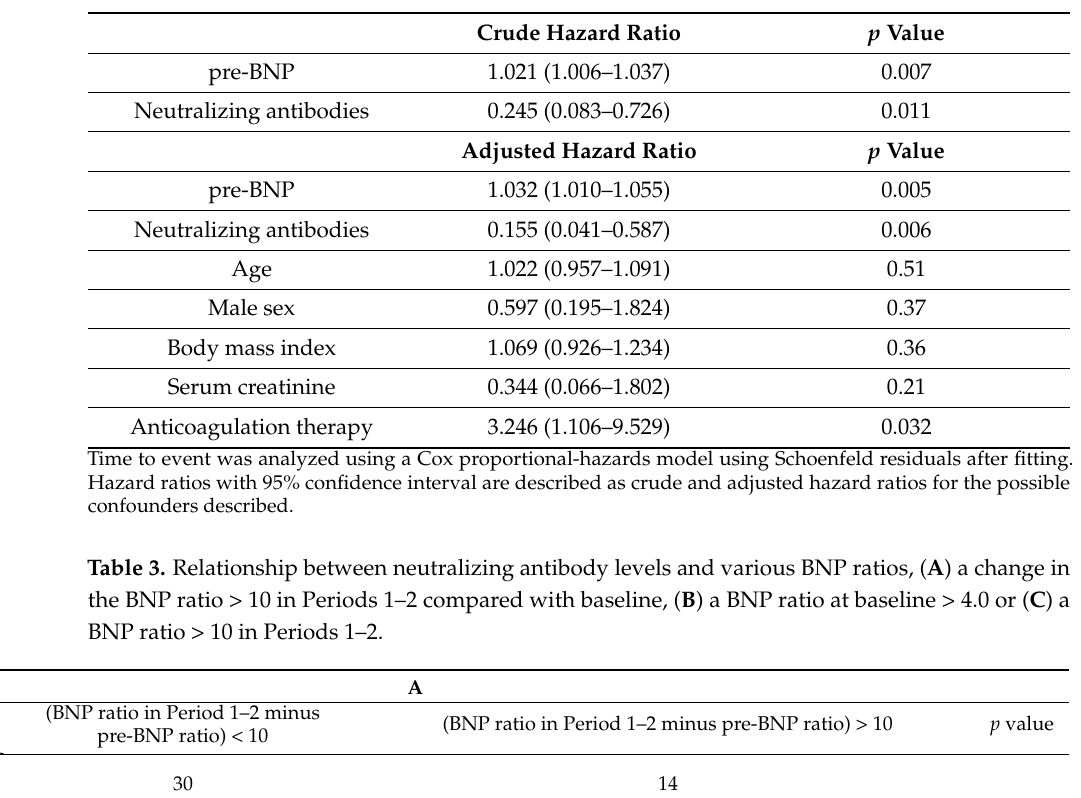
Figure 1. Event-free probability during the clinical course according to brain natriuretic peptide ratio at baseline (pre-BNP) and neutralizing antibody levels. ( A ) A high brain natriuretic peptide ratio at baseline > 4.0 and ( B ) low neutralizing antibody levels < 220 U/mL were significant predictors of clinical events. The number of clinical events continued to increase throughout Periods 1 to 3, and their time course was not affected by the third vaccination. §, first vaccination at Day 0; † , border between Periods 1 and 2 at Day 125 from § ; §§ , timing of the third vaccination, which is the border between Periods 2 and 3 at 258 ± 24 days from § ; †† , end of Period 3 at 399 ± 22 days from § . Table 2. Hazard ratios for the combined outcome.